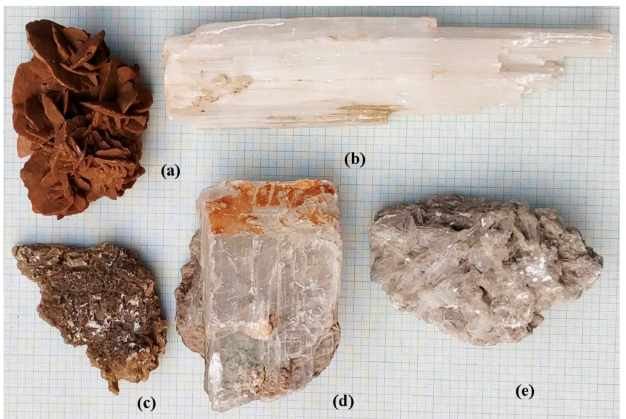
Figure 1. Specimens used in the present study and they include ( a ) Desert Rose Gypsum, Sahara Desert, Morocco (MDRG). ( b ) Acicular Gypsum, Morocco (MAG). ( c ) Gypsum, Kachchh, Gujarat, India